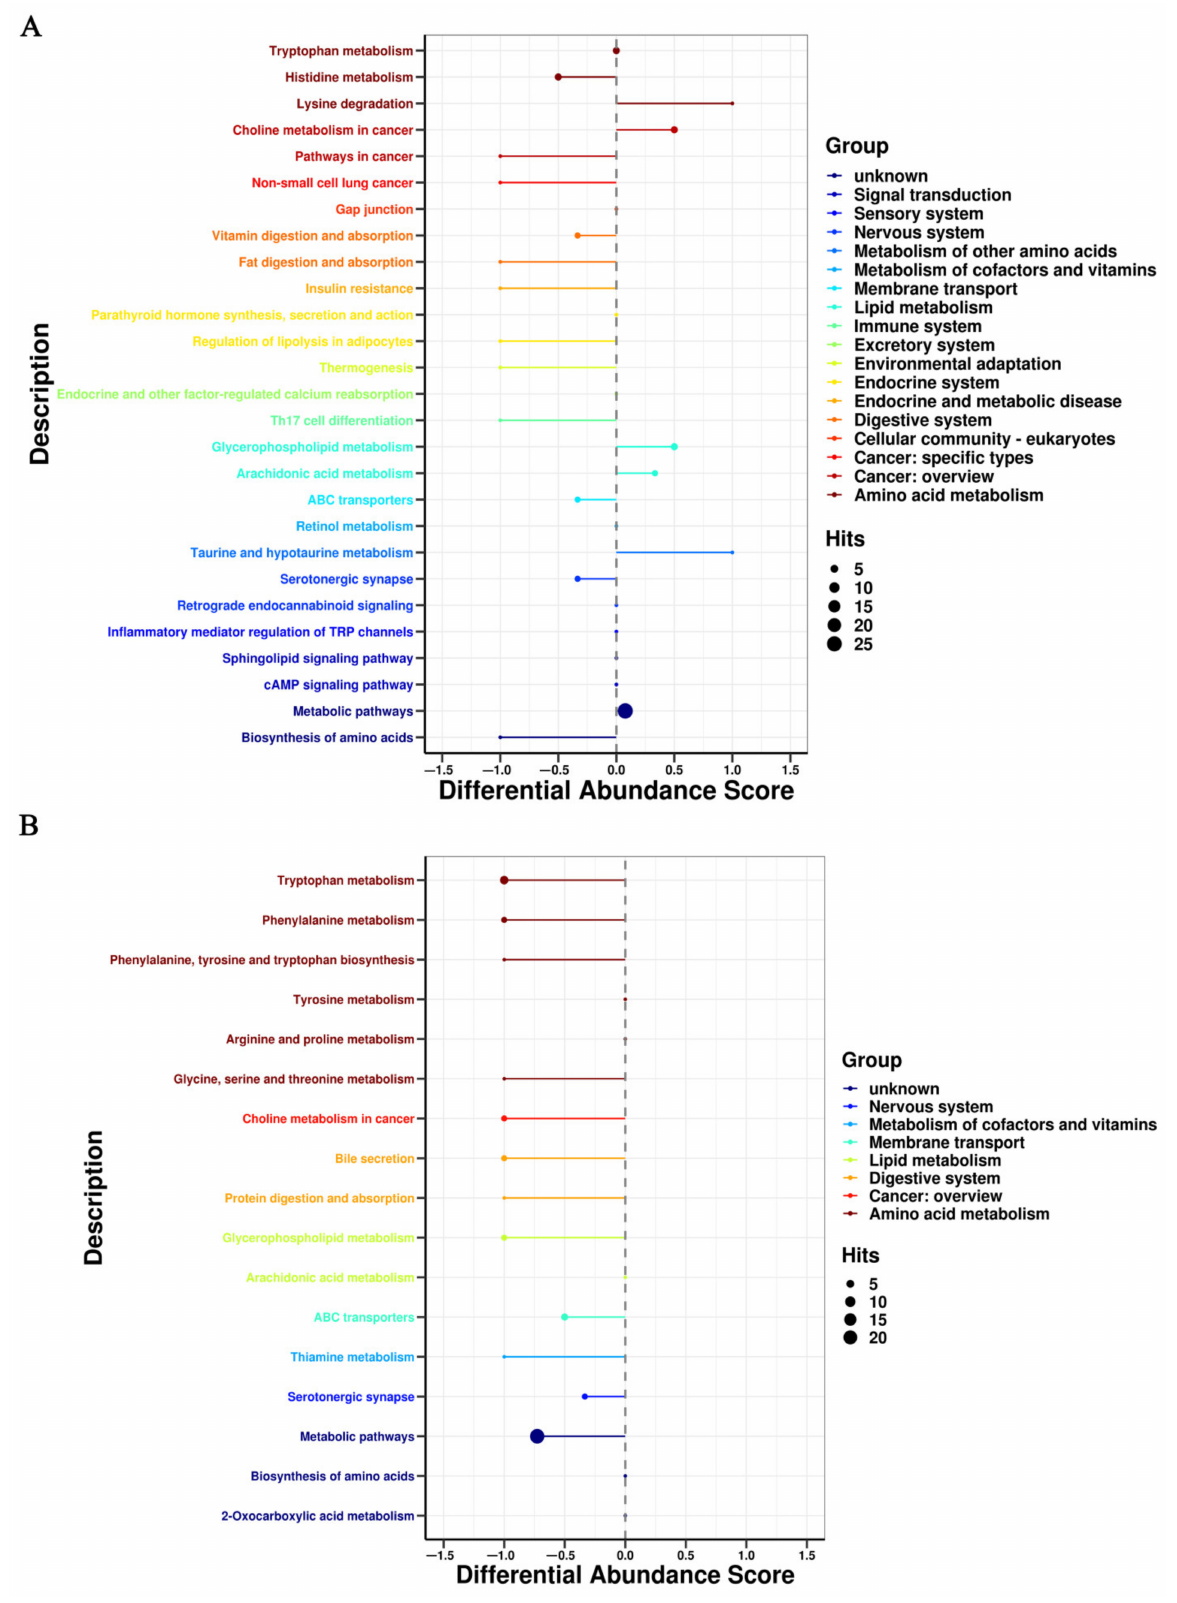
Figure 3. The disturbed pathway analysis using DA score in the ESI+ mode. ( A ) HF versus CT group. ( B ) HF4H versus HF